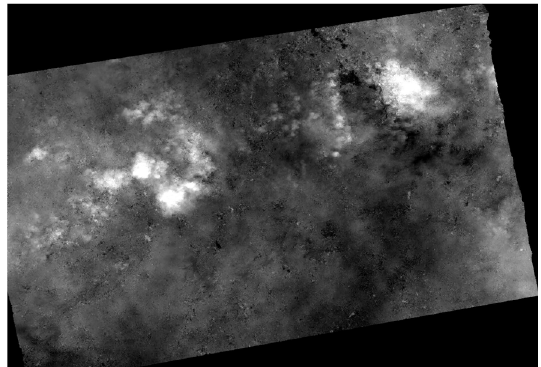
Figure 6. Interferogram after filtering